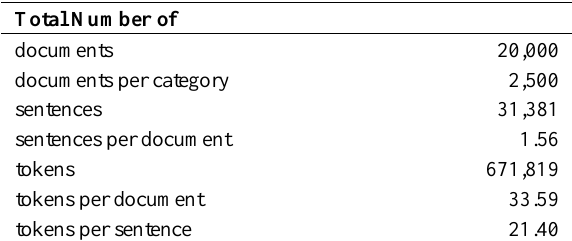
Table 4. Some statistical properties of the data set